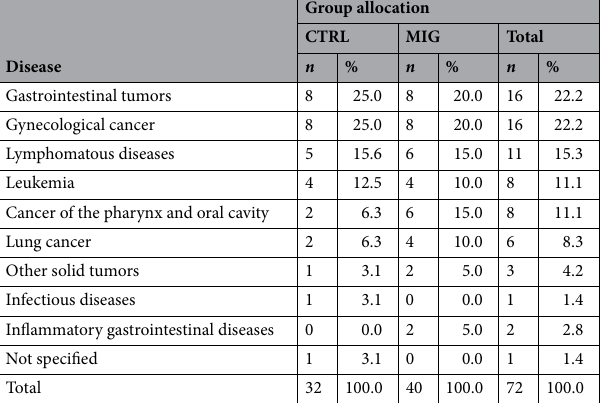
Table 2. Underlying diseases within CTRL and MIG. Pearson Chi-Square: p = 0.712. CTRL control group; MIG music intervention group.